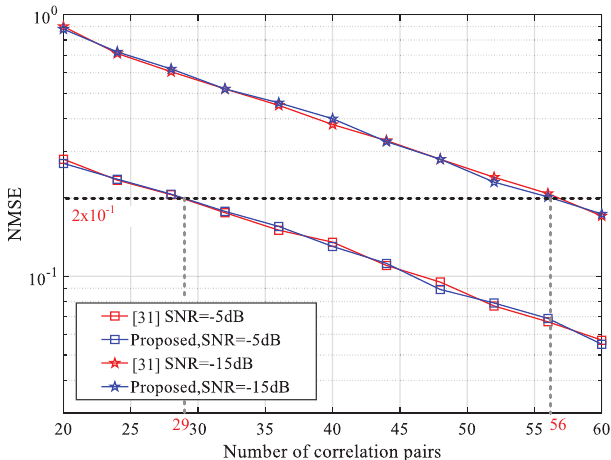
Figure 13. Comparison of frequency tracking performance vs. different numbers of correlation pairs under normal coverage and extended